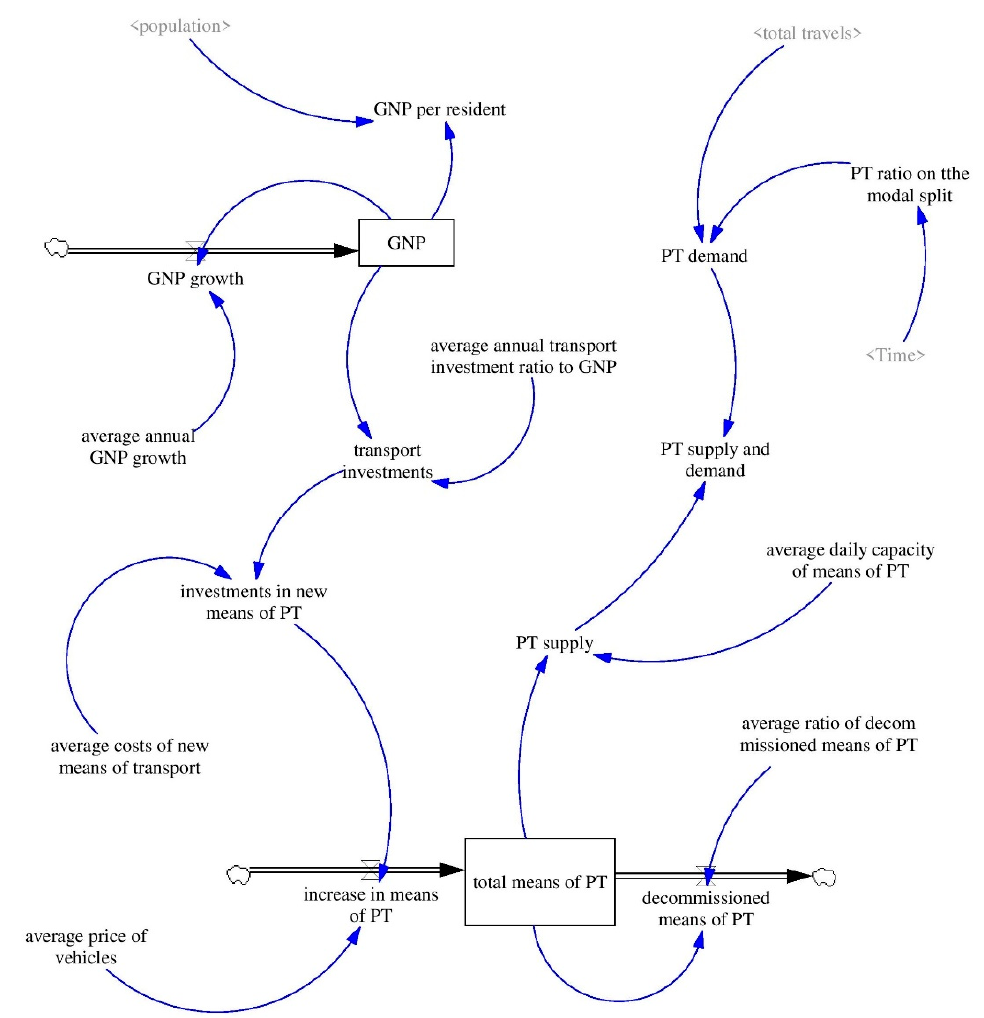
Figure 3. Supply and demand estimation model in CT and PT–second part of the model (source: Authors).